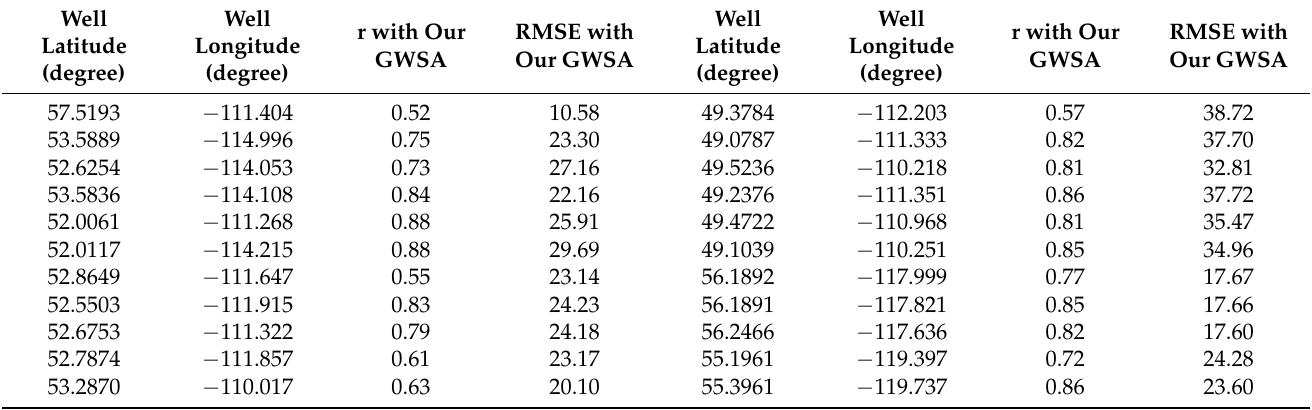
Table 1. Correlations (r) and RMSEs [mm] between our downscaled groundwater storage anomalies